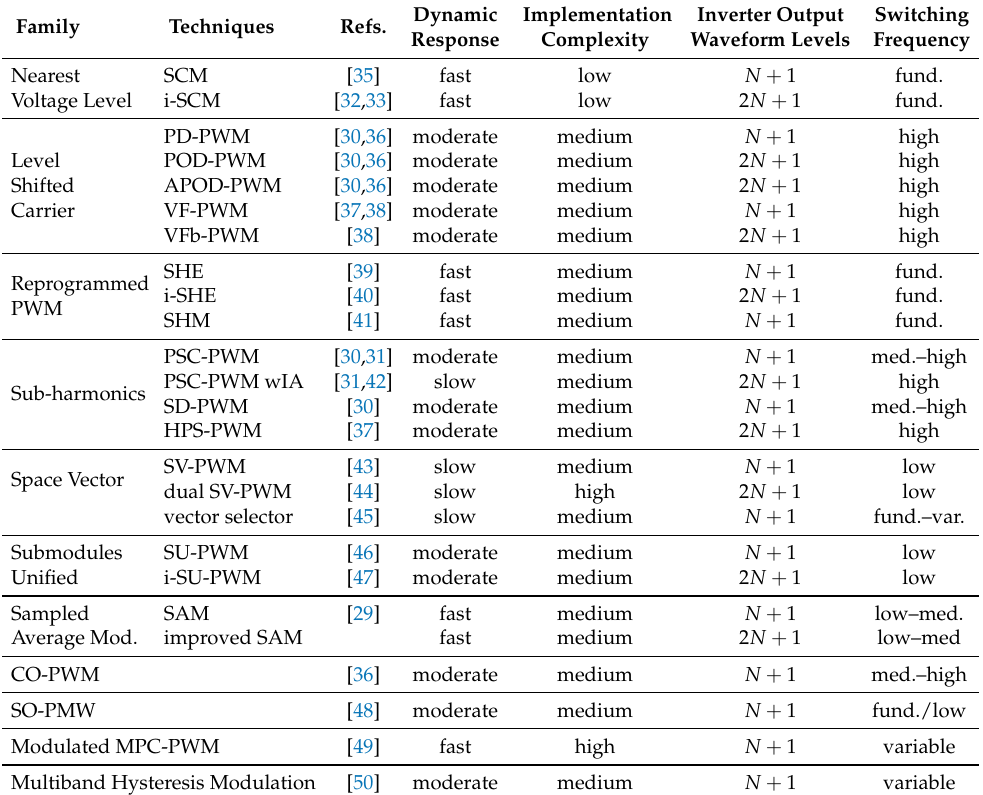
Table 1. Brief overview of power converter modulation techniques applied to